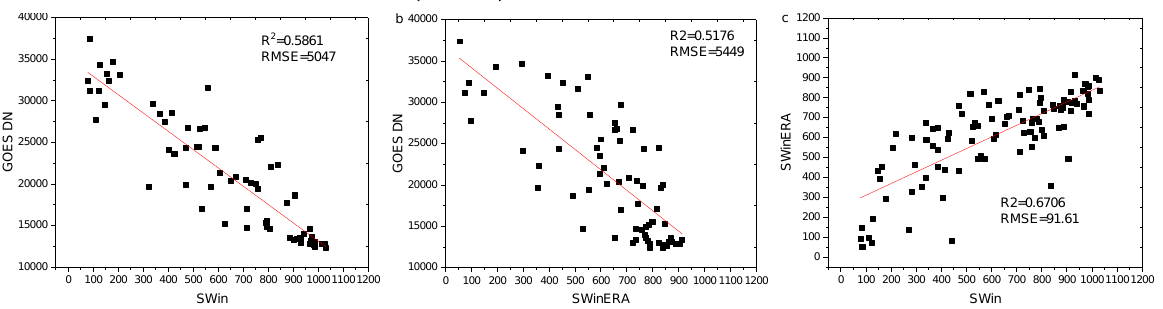
Figure.1 Comparison of satellite based DN values with in-situ measurement Shortwave radiation input in 9:00. GOES DN is the GOES-13 visible band’s record. SWinERA is the ERA reanalysis downward shortwave radiation and SWin is the flux tower in-situ measurement downward shortwave radiation (in W/m2).